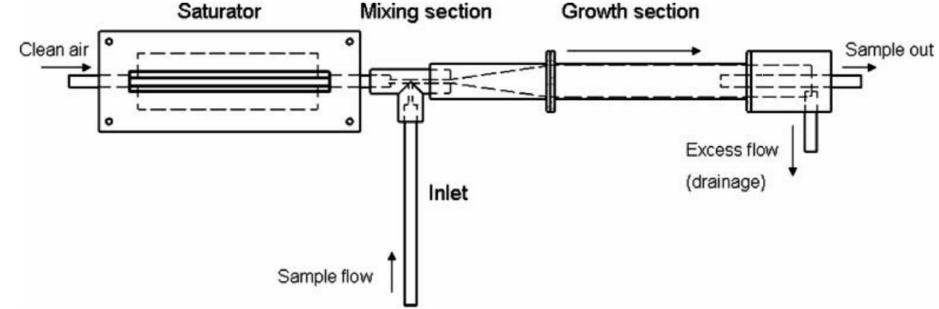
Figure 1. A schematic figure of the Particle Size Magnifier (PSM) (reproduced from Vanhanen et al.,